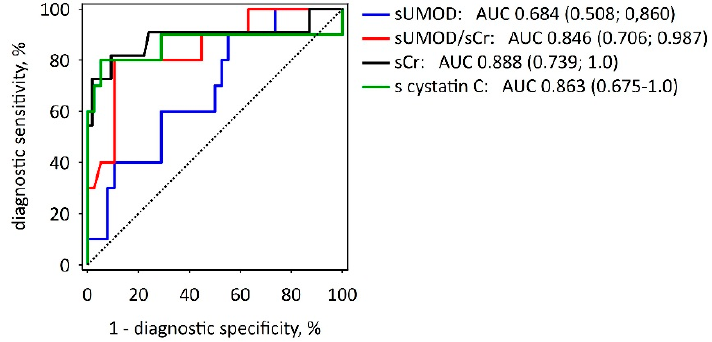
Figure 2. Receiver operating characteristic curves showing the diagnostic utility of selected serum markers measured at 24 h from the onset of AP symptoms in prediction of AKI in the course of AP. The values of area under curve (AUC) with 95% confidence intervals (in brackets) are reported for serum uromodulin (sUMOD), sUMOD/serum creatinine ratio (sUMOD/sCr), serum creatinine alone (sCr), and serum cystatin C (s cystatin C). The diagonal dotted line is the line of no-discrimination. Serum uromodulin concentrations measured during first 48 h of AP were negatively